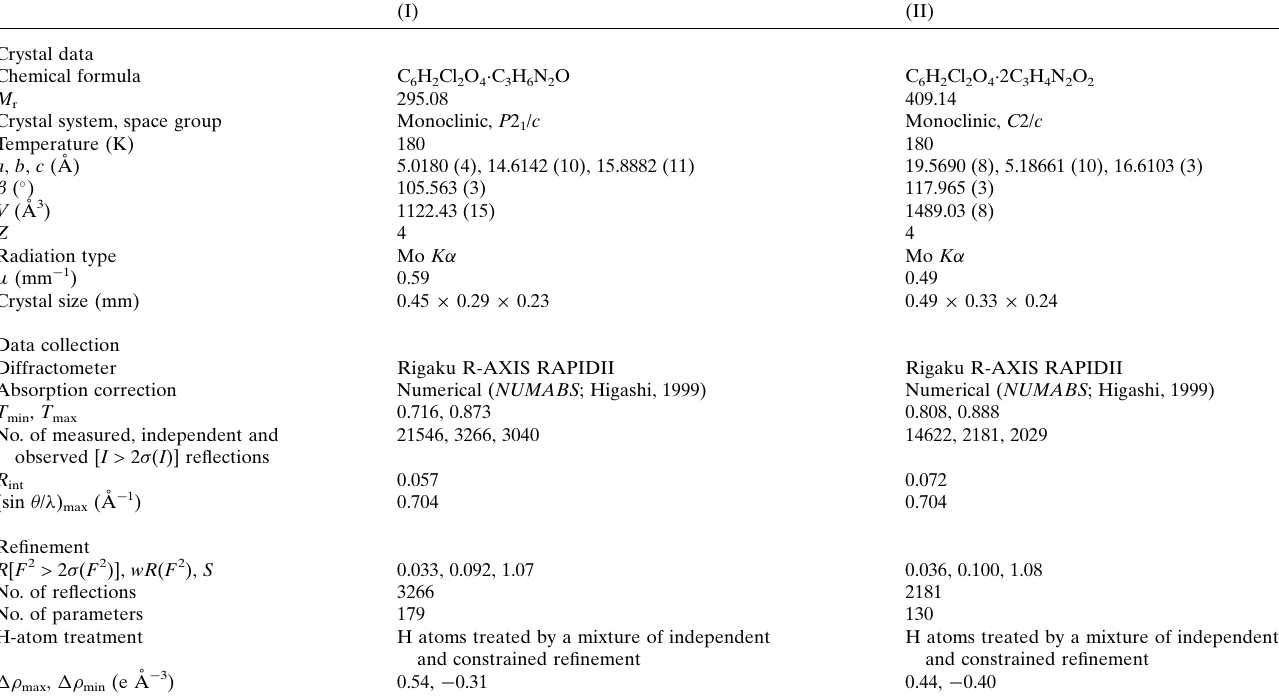
Table 3 Experimental details.